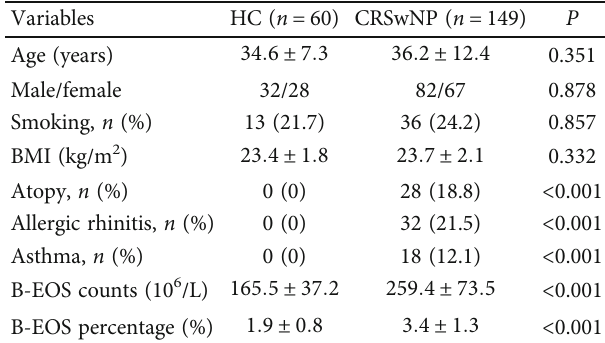
Table 1: Demographic and clinical characteristics of all participants.